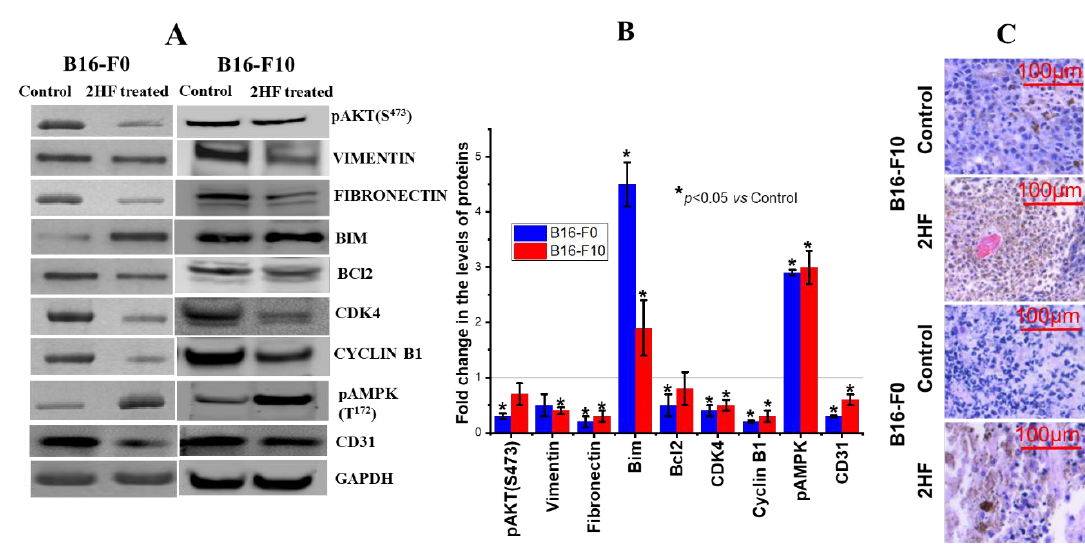
Figure 9. Effects of 2HF treatment on markers of intracellular signaling in tumors. Western blot analyses of signaling proteins in tumor tissue lysates in control and topically 2HF in PLO gel (12 or 20 mg/0.1 mL)-treated experimental groups ( A ). The bar diagrams represent the fold change in the levels of proteins as compared to control (dotted line) as determined by densitometry ( n = 4) ( B ). Photomicrographs of hematoxylin and eosin (H&E) staining of tumor sections. Control H&E-stained sections of dissected tumors show the intact tumor cell structure. Cells have distinct nuclei with a thin uniform cytoplasmic rim around each individual cell. Tumors treated with 2HF show a non-uniform thickened rim of cytoplasm around the damaged nuclei ( C ).